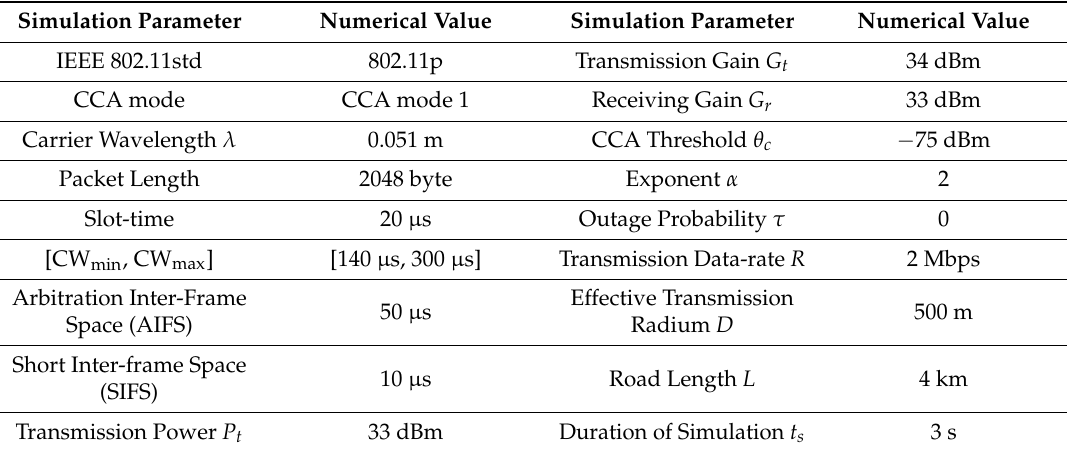
Table 3. Simulation